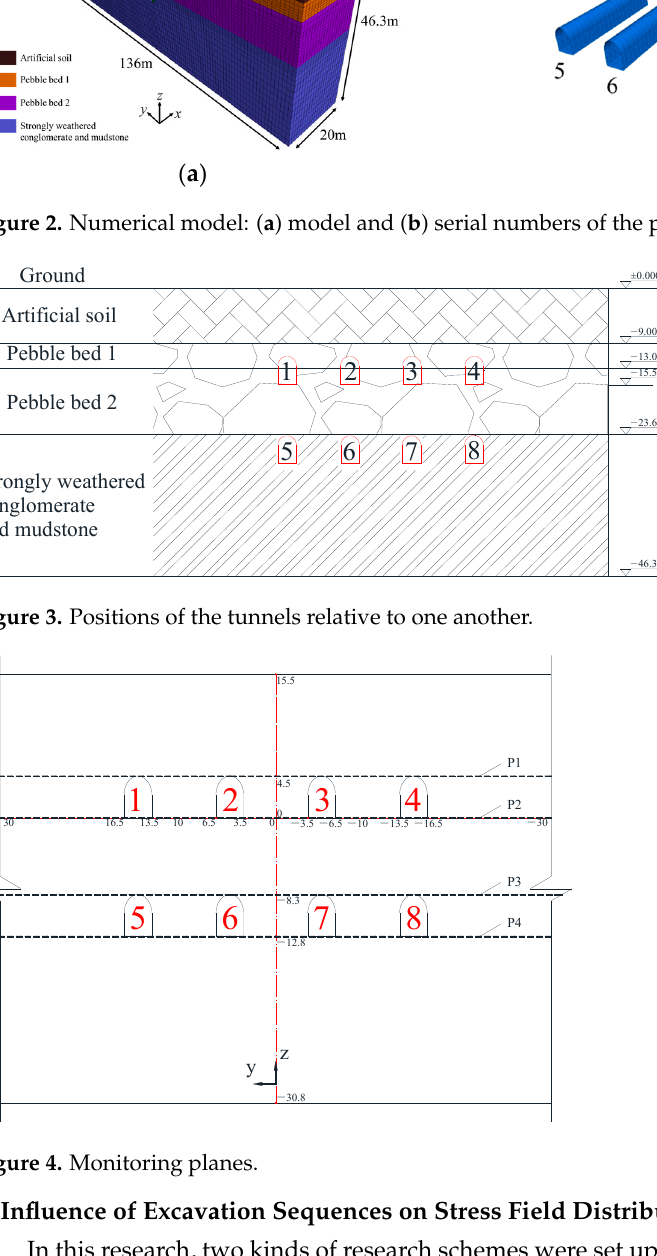
Figure 4. Monitoring planes.